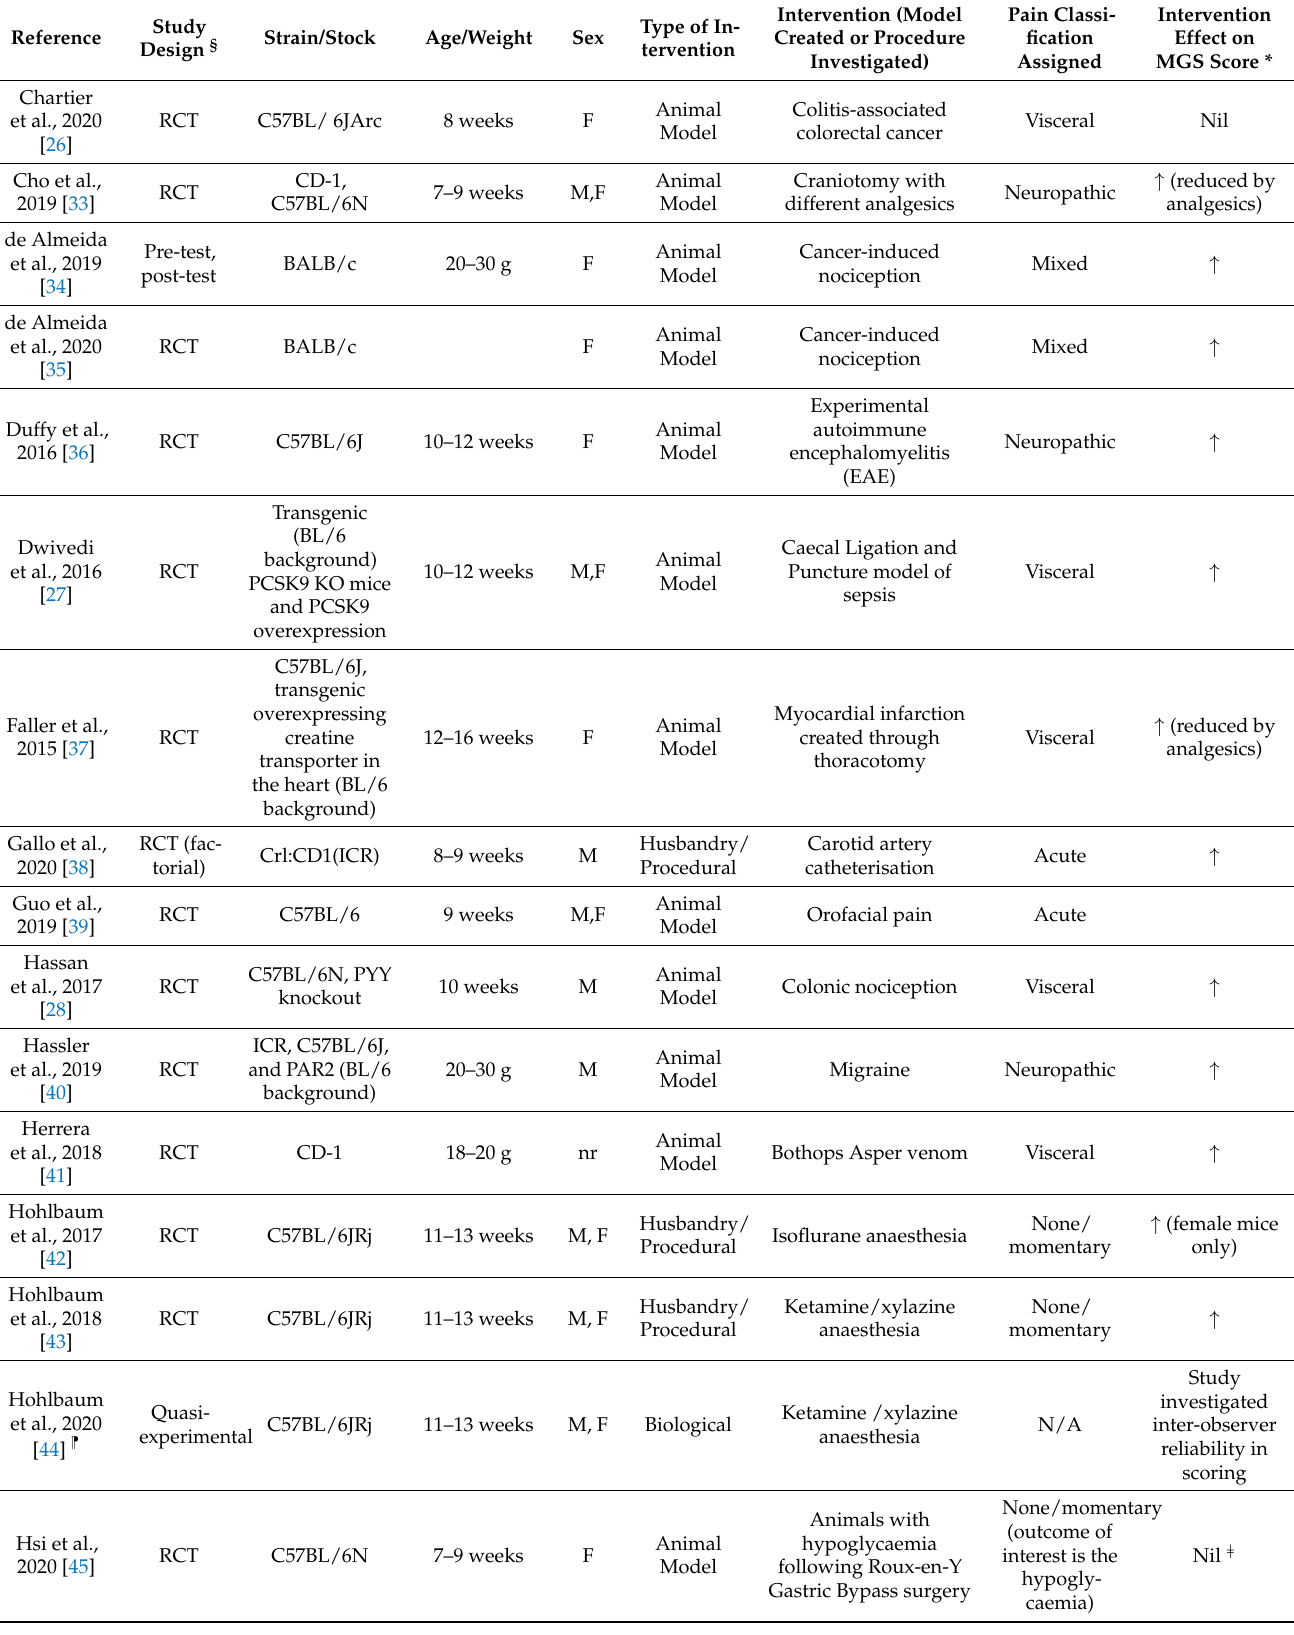
Figure 2. Number of publications per year investigating the Mouse Grimace Scale (MGS) in rela- tion to